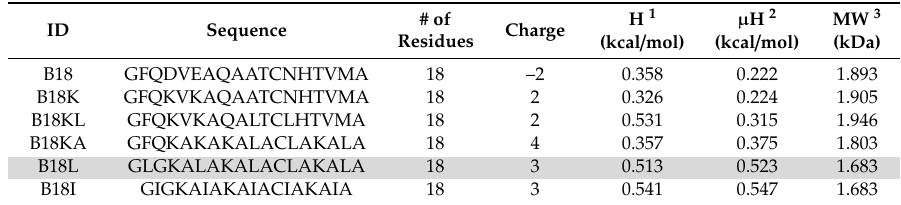
Table 1. B18 and B18-derived